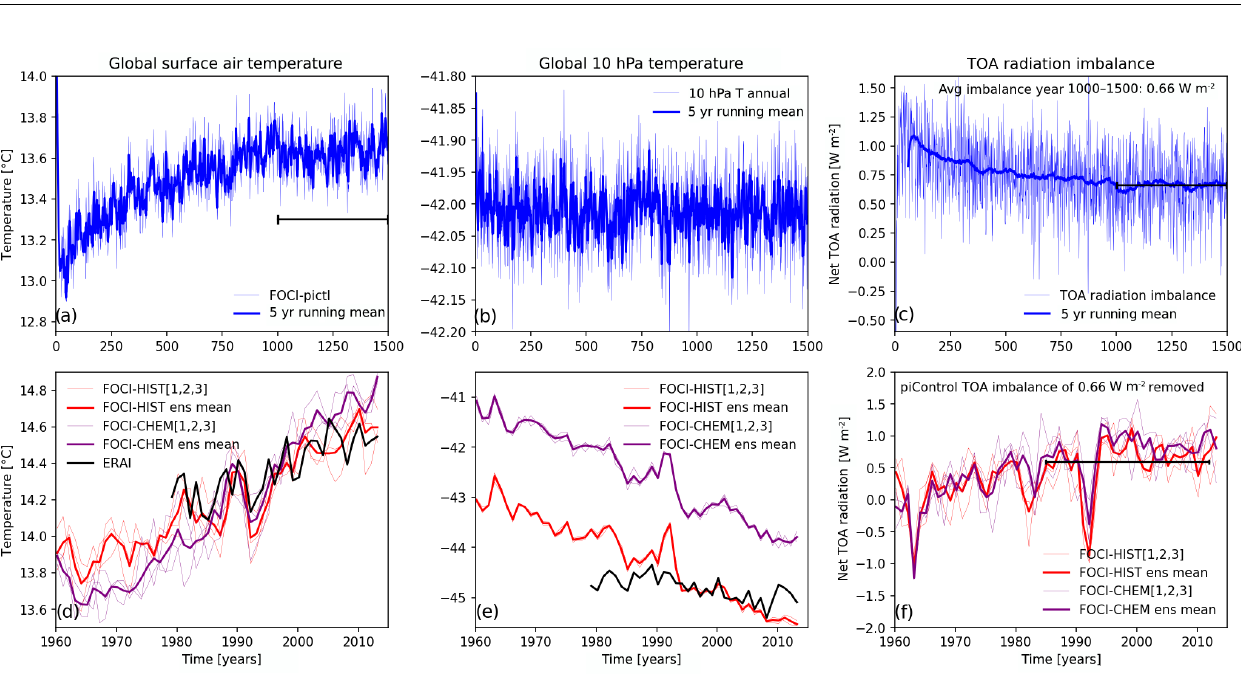
Figure 3. (a) Global surface air temperature, (b) global 10hPa temperature and (c) top of the atmosphere (TOA) radiation balance from FOCI-piCtl. The black bar in panel (a) highlights years 1000 to 1500 which are used to evaluate the mean state of FOCI throughout this publication. The black bar in panel (c) highlights the average radiation imbalance of +0.66Wm − 2 . (d) Global surface air temperature, (e) 10hPa temperature and (f) TOA radiation balance (with the mean TOA radiation imbalance indicated in panel c subtracted) from the FOCI- hist and FOCI-chem experiments from 1950 to 2013. For the historical period (d, e) , the ERA-Interim reanalysis temperature is included as an observational estimate. The black bar in panel (e) shows the average radiation imbalance of 0.59Wm − 2 from 1985 to